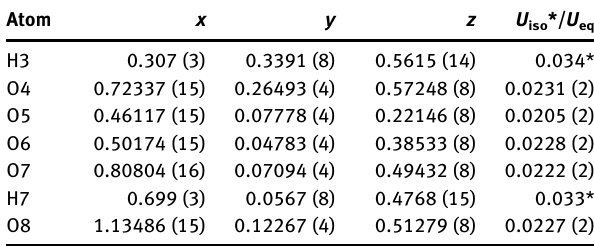
Table  : Fractional atomic coordinates and isotropic or equivalent isotropic displacement parameters (Å 